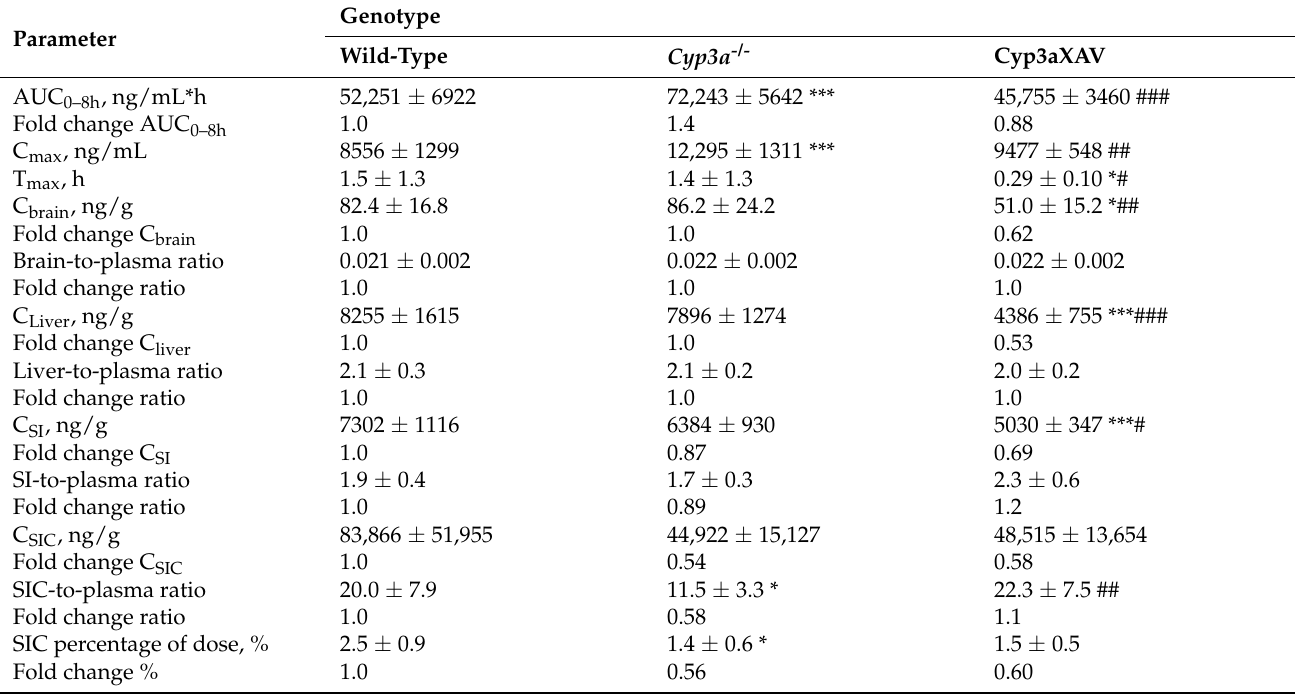
Table 4. Plasma and organ pharmacokinetic parameters of selpercatinib in female wild-type, Cyp3a -/- and Cyp3aXAV mice over 8 h after oral administration of 10 mg/kg